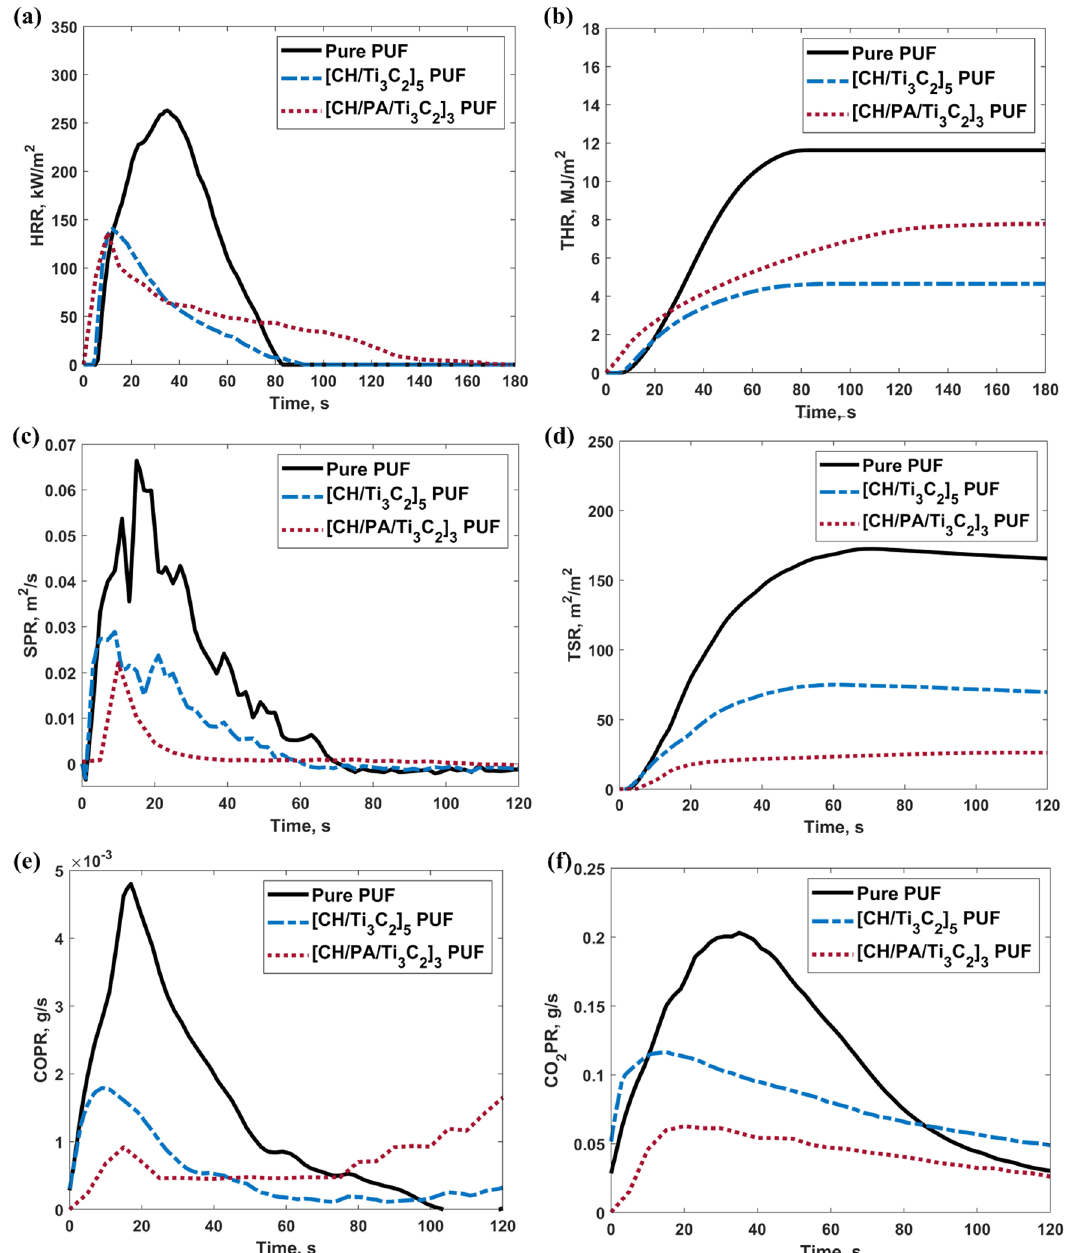
Figure 6. Cone calorimetry results of ( a ) HRR, ( b ) THR, ( c ) SPR, ( d ) TSR, ( e ) COPR and ( f ) CO 2 PR of the pure and all coated